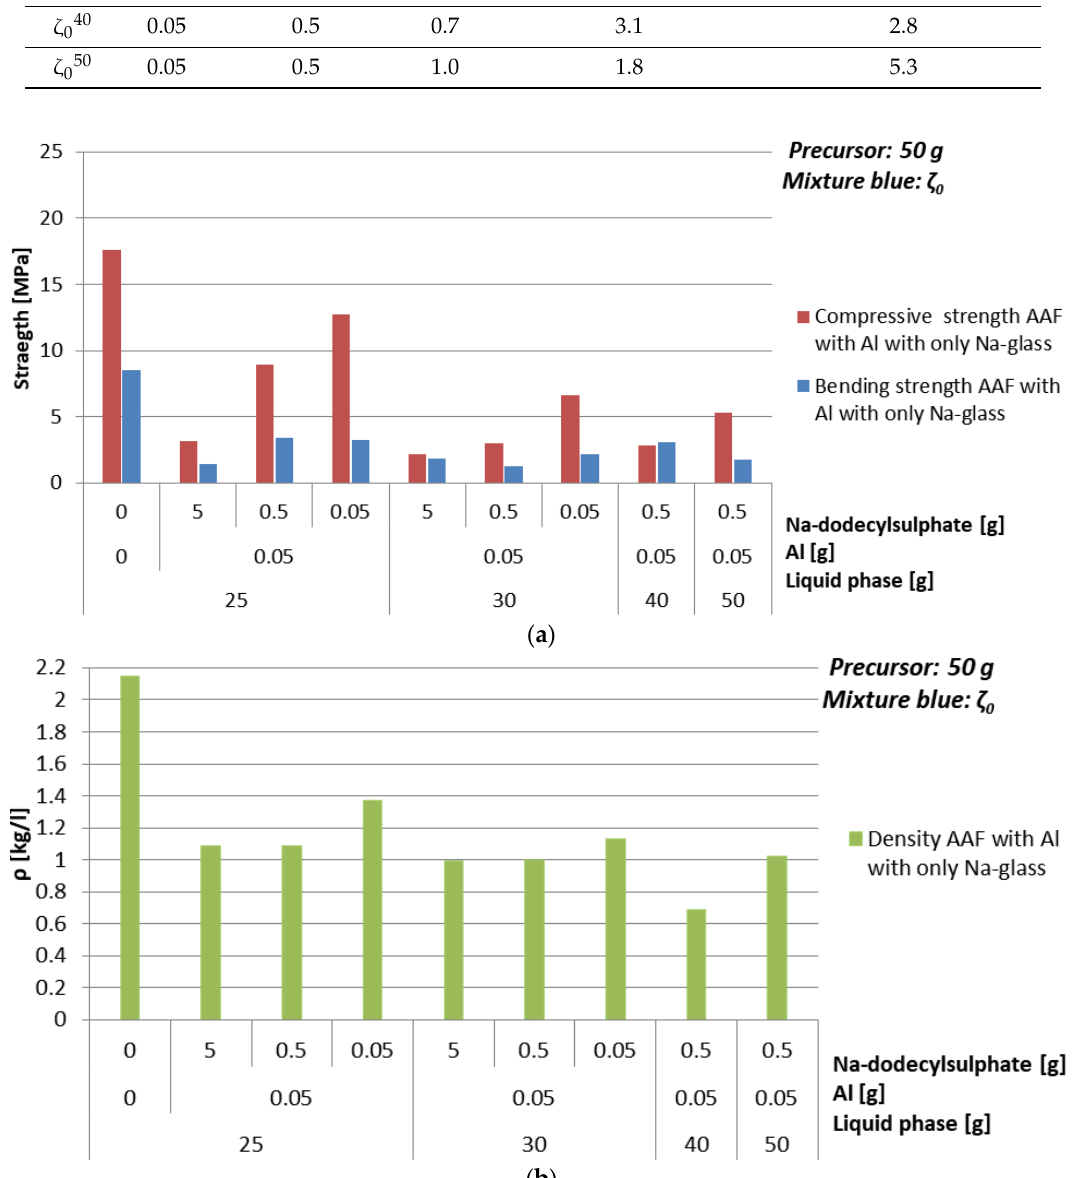
Figure 11. ( a ) Bending and compressive strength, and ( b ) density of AAF, produced by Al powder using mixture ζ 0 , cured on 70 °C for one day, measured one week after molding.